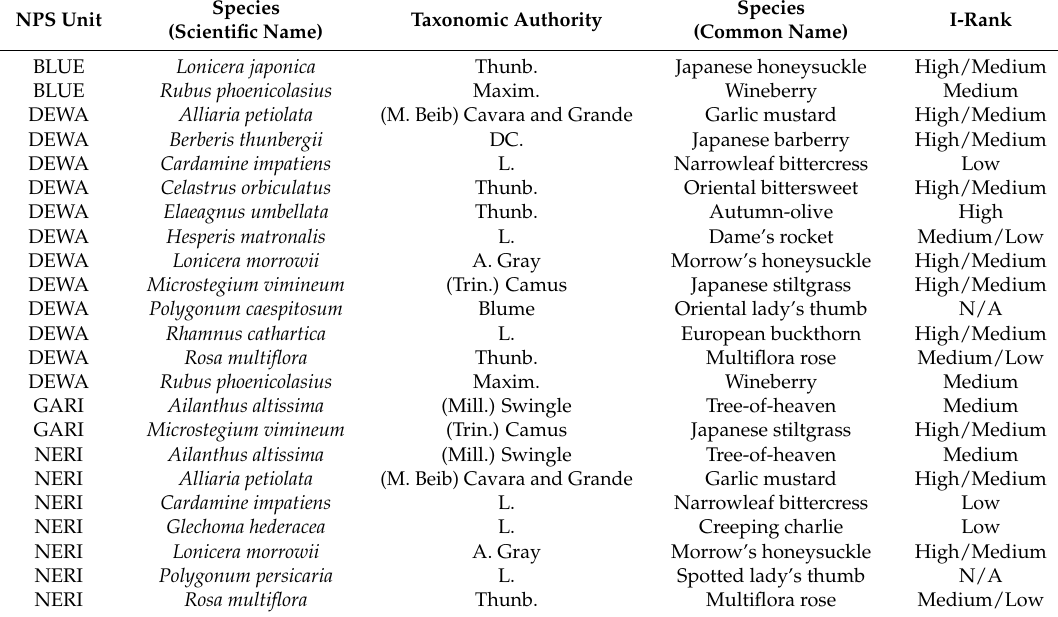
Table A8. List of exotic plants by NPS unit with their U.S. Invasive Species Impact Rank (I-Rank). This table shows all of the exotic plants present in the quadrats of the disturbed plots. I-Rank is a ranking system established by NatureServe, The Nature Conservancy, and the NPS, which assesses exotic plants within the U.S. to determine which species may have the most detrimental impacts to native species and ecosystems. Not all species have been assessed for level of invasiveness. Unassessed species are ranked “N/A.” (For more information see http://explorer.natureserve.org/impact_rank.htm).